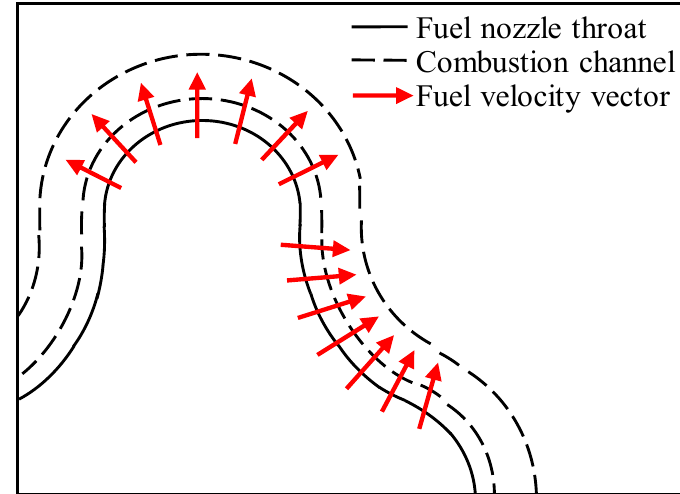
Figure 15. Schematics fuel injection characteristics of tri-arc RDE.